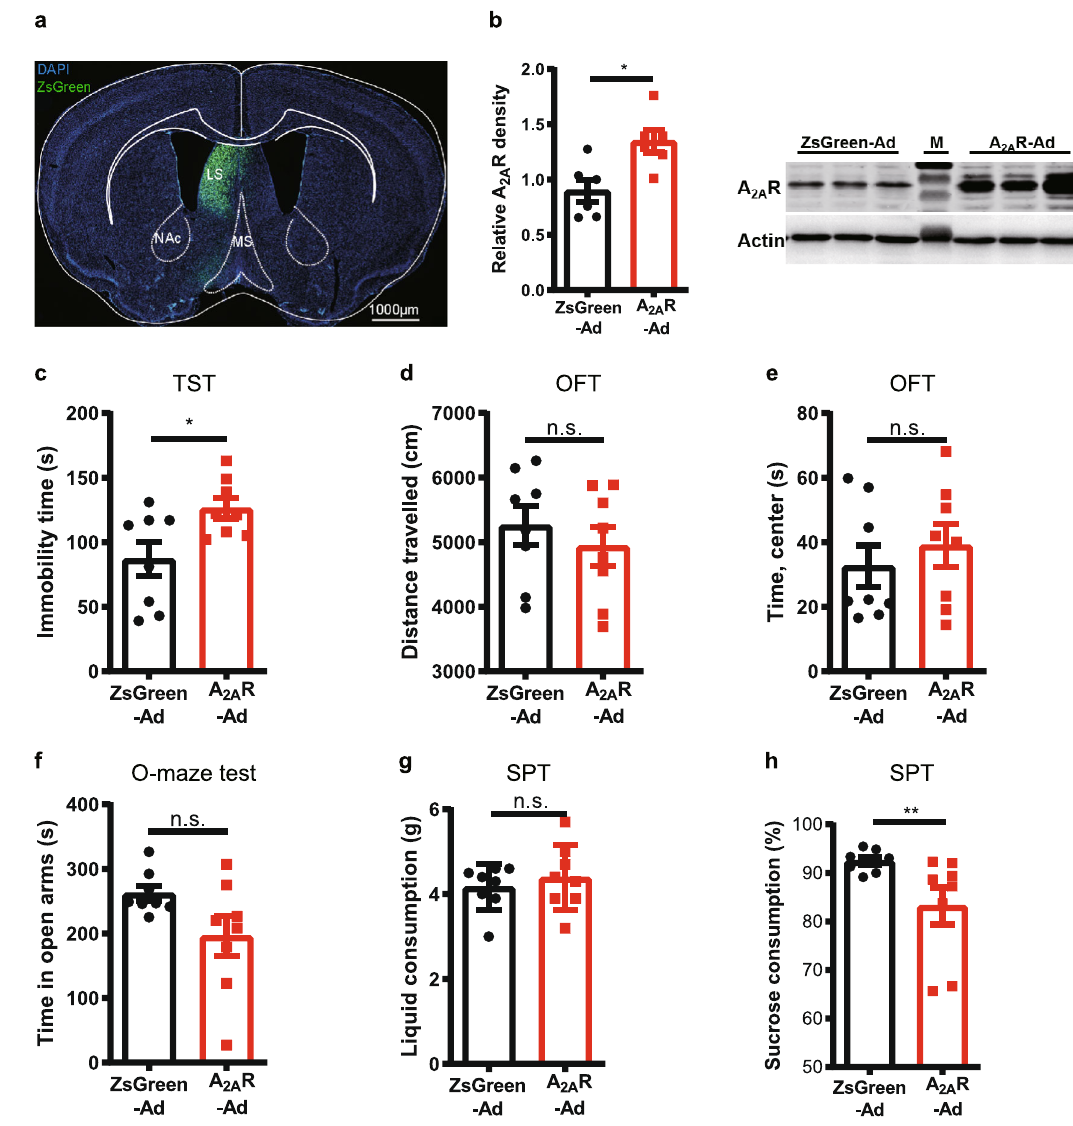
Fig. 7 | A 2A R overexpression in the lateral septum (LS) induces depression-like t(14)=0.7530) d or the time in the central area in the open fi eld test (OFT) ( n =8 behaviors. a Adenovirus expressing A 2A R (A 2A R-Ad) and ZsGreen (ZsGreen-Ad) in mice/group, Mann-Whitney test, p =0.6454, U=27) e and in the elevated O-maze the LS. Nuclei are stained with DAPI in blue. MS, medial septum; NAc, Nucleus test ( n =8 mice/group, Unpaired t test with Welch ’ s correction, p =0.0784, Welch- Accumbens core. Scale bar: 1000 μ m. b Representative Western blots and quanti- corrected t(8.9)=1.988) ( f ). A 2A R-Ad mice displayed similar total liquid consump- fi cation of A tion ( n =8mice/group,Mann – Whitney test, p =0.7033,U=28)( g )buta decreased 2A receptor protein levels of mice injected with A 2A R-Ad and ZsGreen- Ad ( n =6 mice/group, Unpaired t test, p =0.0106, t(10)=3.135). c – h Compared to consumption of sucrose compared with the control group ( n =8 mice/group, control mice, A 2A R-Ad mice displayed increased immobility in the tail suspension Mann-Whitneytest, p =0.0070,U=7)( h )inthesucrosepreferencetest(SPT).Data were shown as mean±SEM. * p <0.05, ** p <0.01; n.s., no signi fi cant difference. test(TST)( n =8mice/group,Unpairedttest, p =0.0229,t(14)=2.554) c ,nochange Source data are provided as a Source Data fi of the total distance traveled ( n =8 mice/group, Unpaired t test, p =0.4639,